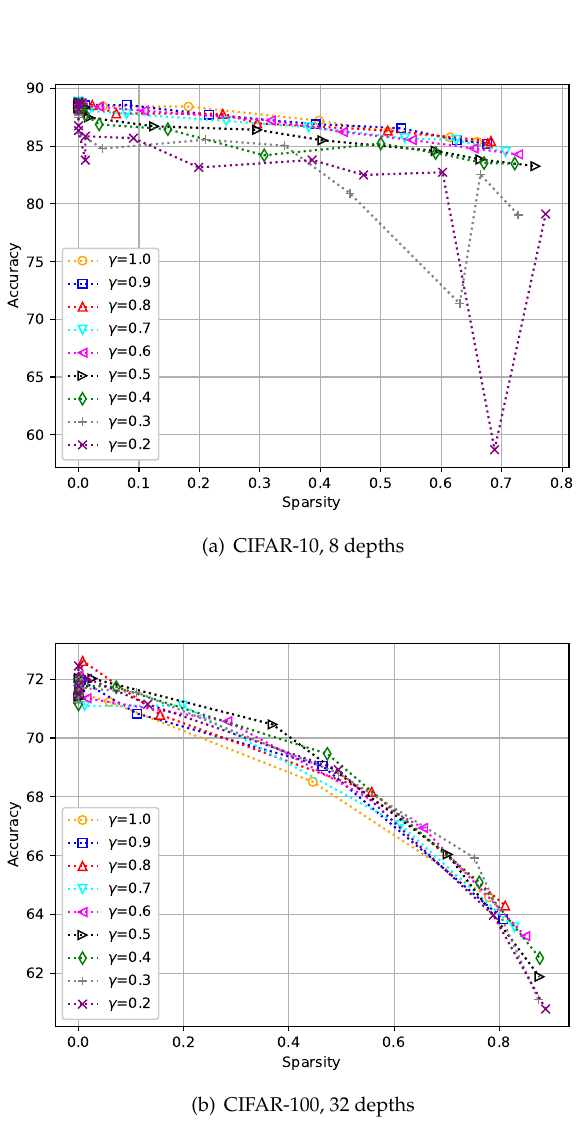
Figure 8. Analysis of the hyper-parameter γ . Here, the hyper-parameter γ is the relaxation variable shown in Equation